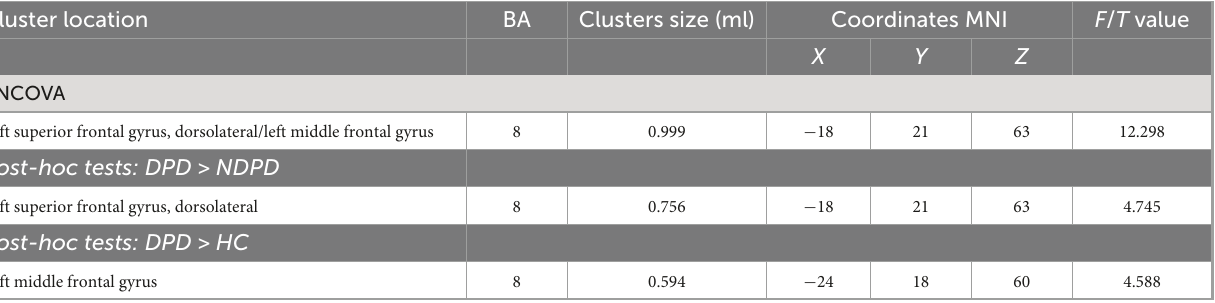
and conform; (2) correction of signal strength non-uniformities caused by magnetic field inhomogeneities; (3) removal of no- brain issue (skull stripping); (4) affine registration to the Talairach atlas and segmentation of the subcortical white matter and deep gray matter structures. (5) tessellation of the gray-to-white and gray-to-cerebrospinal fluid surface boundaries; (6) automatic correction of topology defects; (7) surface deformation for optional placement of the gray-to-white and gray-to-CSF boundaries, two researchers blinded to the participants performed the initial visual inspection of the segmentation and minor manual corrections to the segmentation as needed; (8) smoothing with a 10 mm FWHM Gaussian smoothing kernel; (9) surface inflation and registration to a spherical atlas for intersubject matching of cortical folding patterns; (10) cortical parcellations were based on the PALS- B12 atlas (Van Essen, 2005). For each subject, per hemisphere, FreeSurfer parcellated five cortical regions (frontal, parietal, limbic, temporal, and occipital lobe) based on the PALS-B12 atlas and seven subcortical regions (nucleus accumbens, amygdala, caudate, hippocampus, pallidum, putamen, and thalamus) (Fischl et al., 2002). The regional cortical thicknesses and volumes, subcortical GM volumes, and total intracranial volume (TIV)